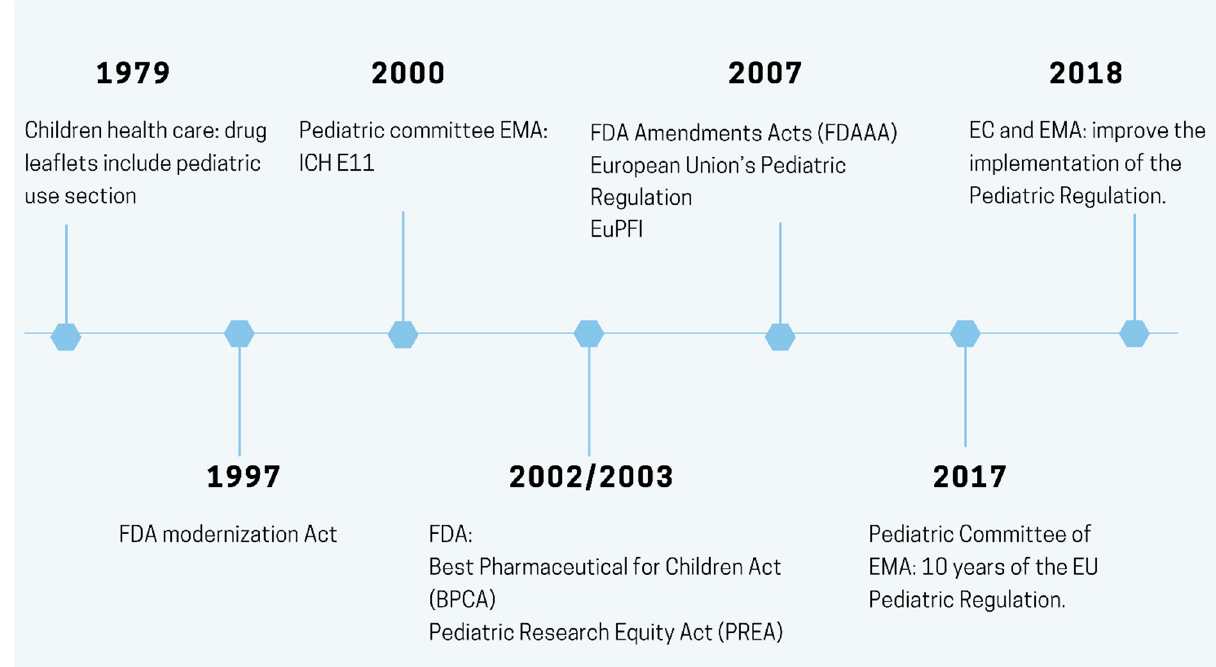
Figure 1. Schematic representation of the key milestones in the regulation of pediatric